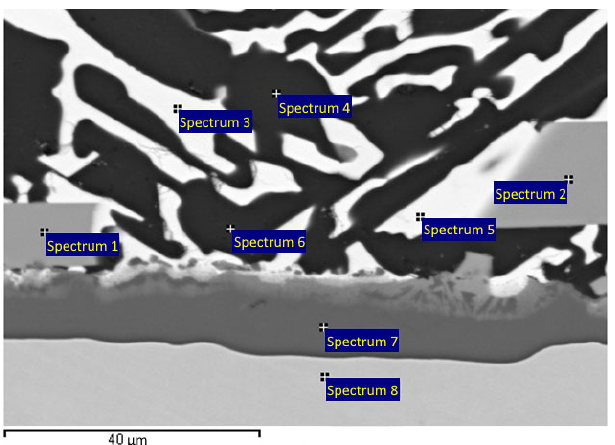
Figure 6. Microstructure of AISI 304 wetted with Al ‐ 40.0Ge ‐ 3.4Si wt.% filler alloy according to 540 °C/10 min mode with EDX measurement points.